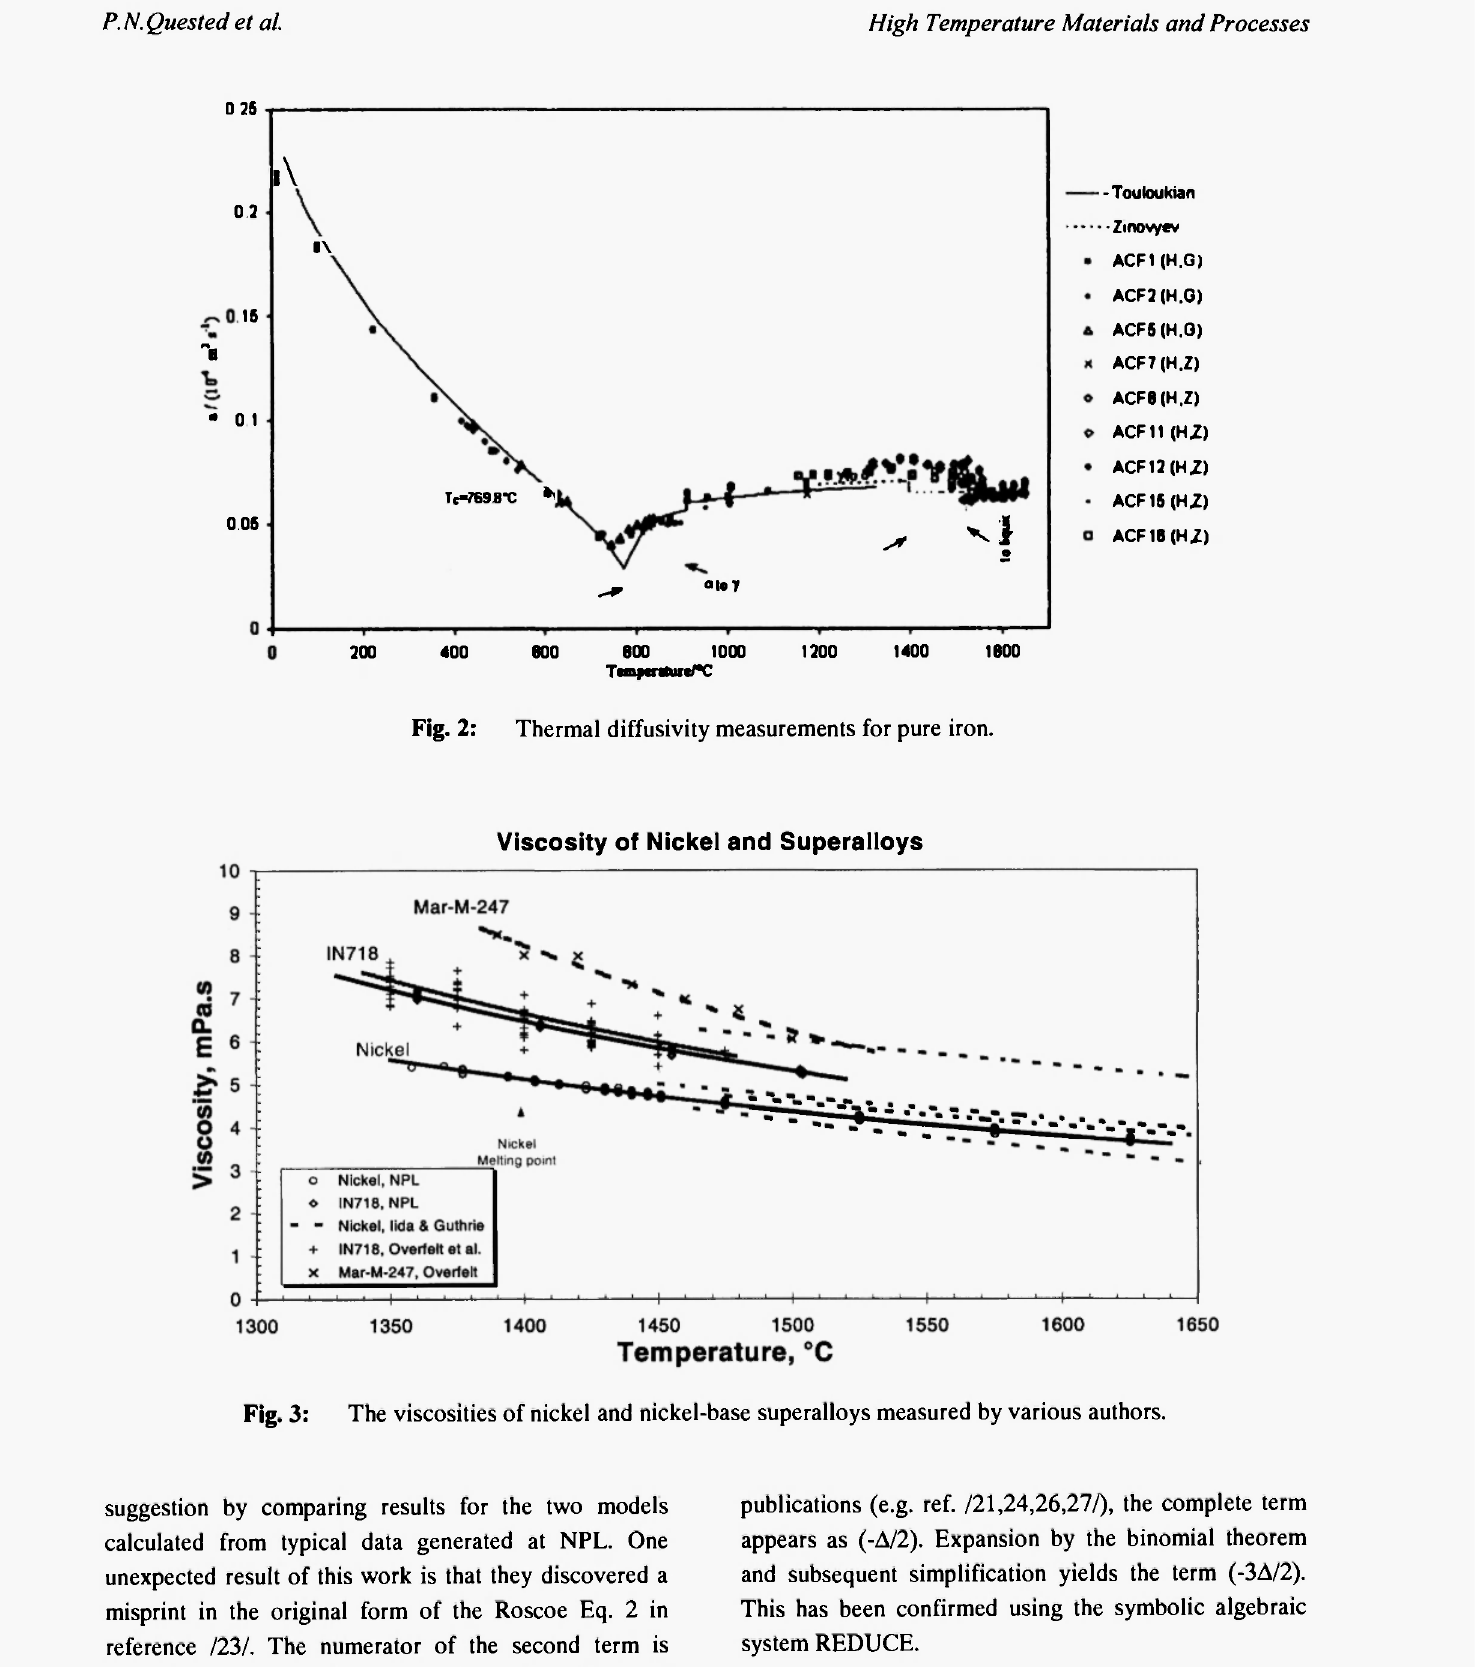
suggestion by comparing results for the two models calculated from typical data generated at NPL. One unexpected result of this work is that they discovered a misprint in the original form of the Roscoe Eq. 2 in reference /23/. The numerator of the second term is omitted. However, in a number of subsequent